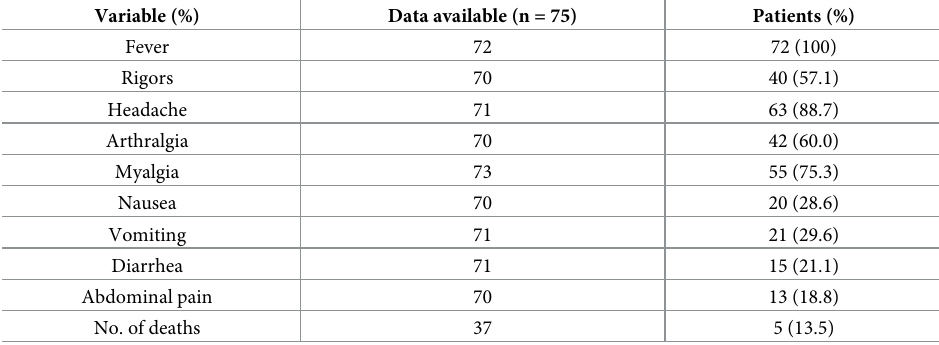
Table 1. Admission clinical characteristics of Leptospira spp. culture positive patients. Variable (%) Data available (n =